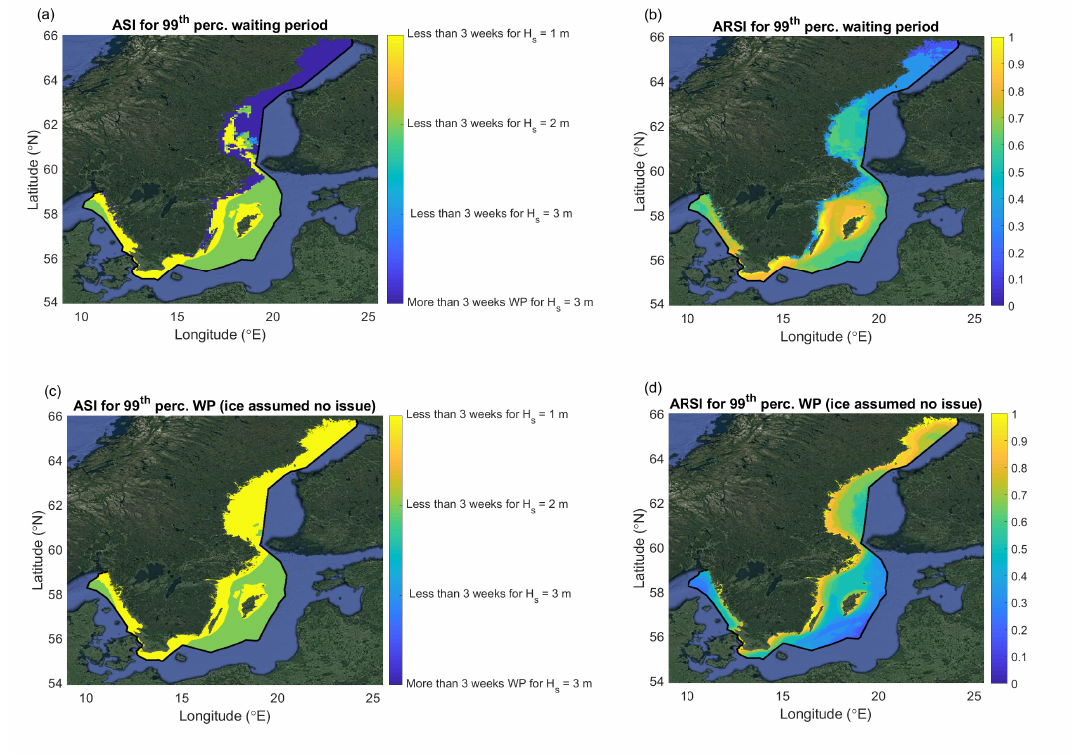
Figure 13. The ASI for 99th percentile waiting periods based on considering if the length of the waiting periods was above or below three weeks for each of the categories (in ( a , c )) and considering the percentile limits to formulate the ARSI in ( b , d ). The sub-plots ( a , b ) refer to considering the ice seen by the wave model as inhibiting when defining waiting periods, and ( c , d ) are the corresponding figures assuming ice is not inhibiting O&M activities. A value of one indicates the best regions with regards to the 99th percentile waiting periods for all categories considered, and low values imply the presence of longer waiting period for many of the categories